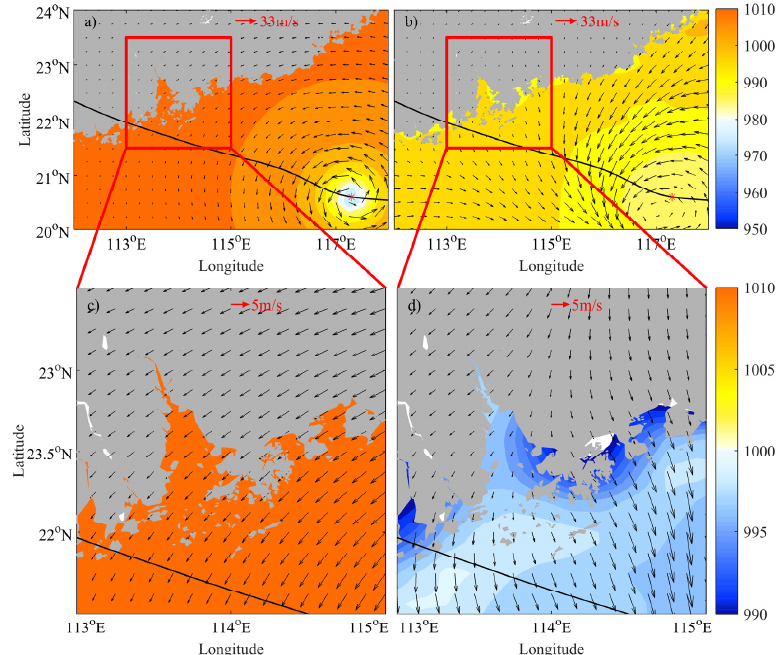
Figure 1. Planar views of Typhoon Hato (2017). ( a – d ) The black lines in ( a – d ) show the path of Typhoon Hato. Wind velocity (black arrows; units: m / s; vectors) and air pressure (units: hPa; shaded) provided by the Holland model ( a , c ) and CFSV2 ( b , d ) at 12:00 UTC on 22 August 2017. The ( c ) and ( d ) are enlarged views of the ( a ) and ( b ),